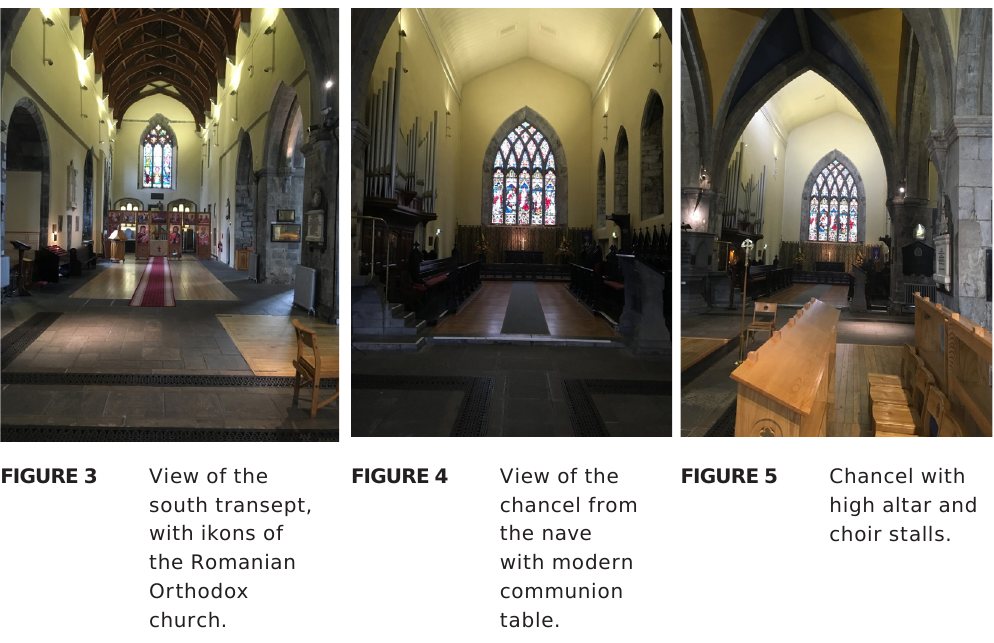
View of the south transept, with ikons of the Romanian Orthodox church.